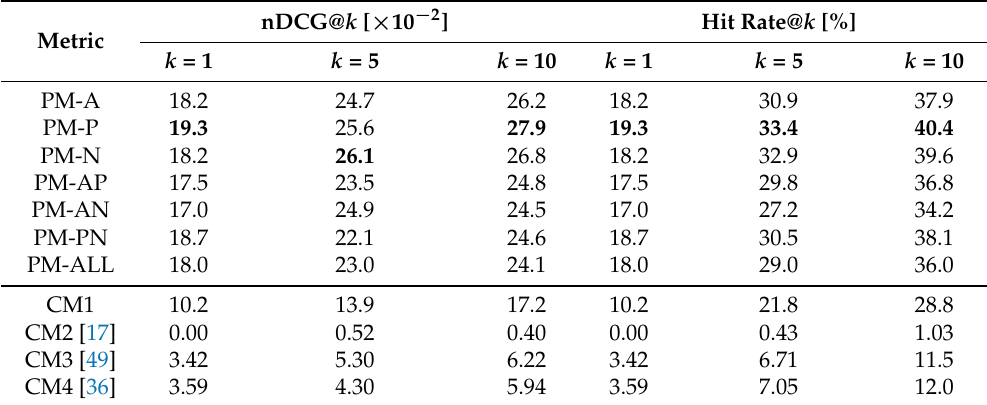
Table 2. The values of nDCG@ k and Hit Rate@ k ( k = 1, 5, 10). The bold values are the maximum values for each evaluation metrics,